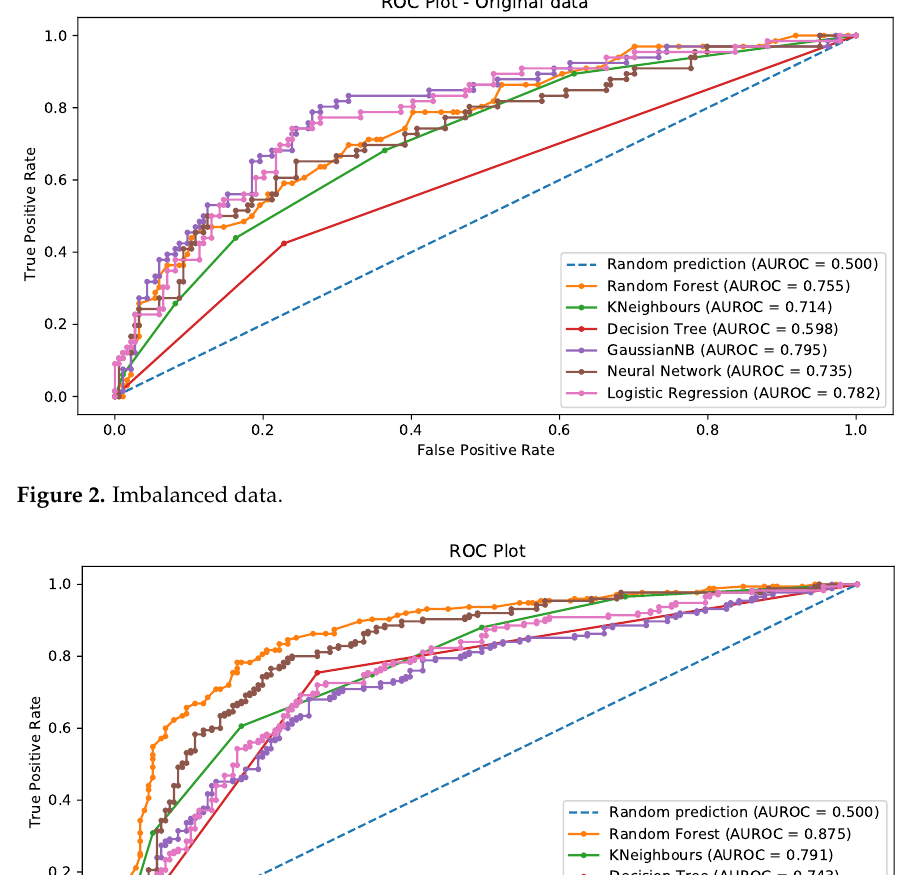
ROC Plot - Original data